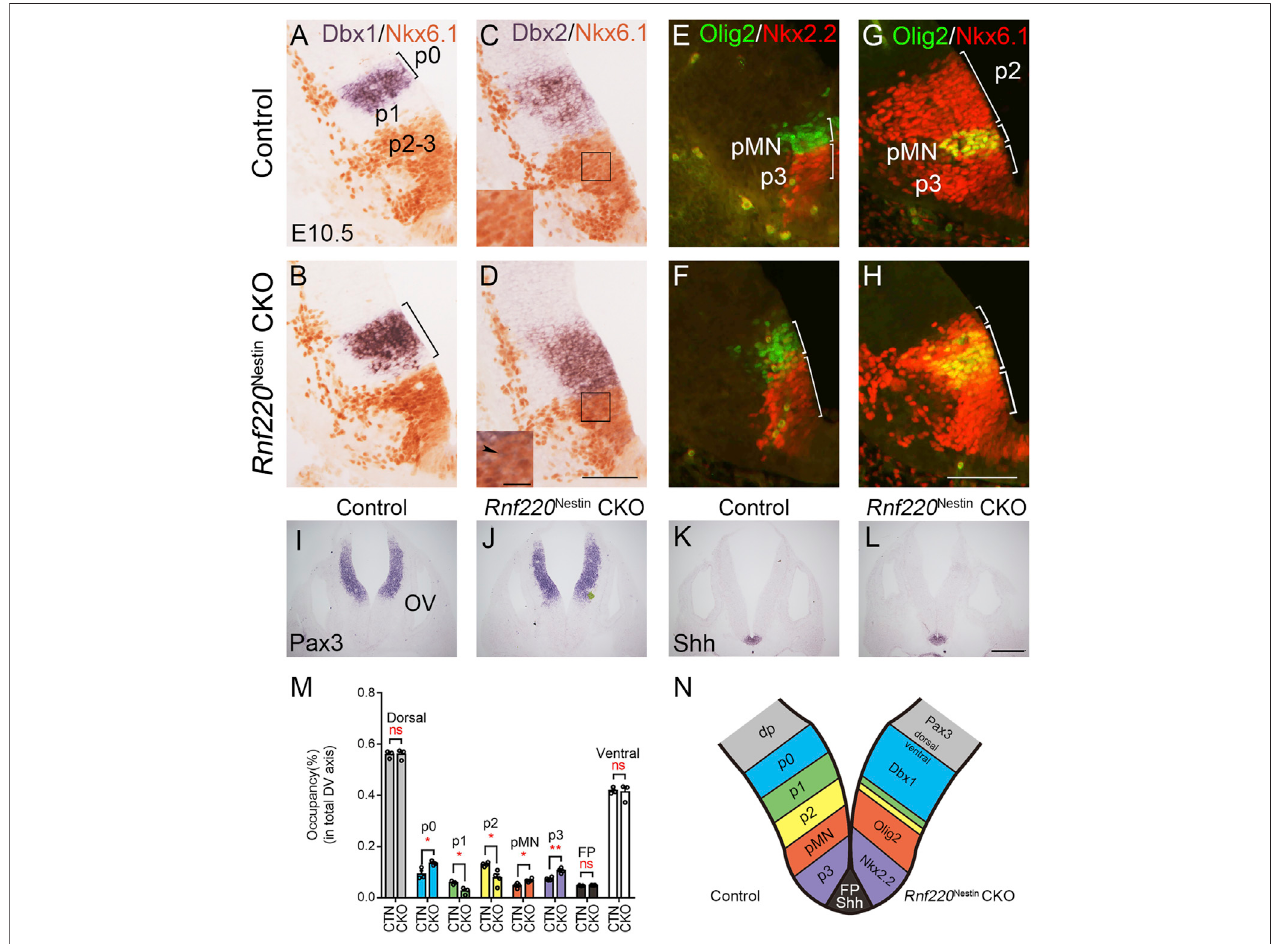
FIGURE2| TheProgenitorDomainsareAlteredintheDevelopingVentralHindbrainof Rnf220 Nestin CKOEmbryosatE10.5. (A,B) Insitu hybridizationfor Dbx1 and immunostaining for Nkx6.1 show that Dbx1 expression is expanded ventrally to the dorsal boundary of the Nkx6.1 + domain in Rnf220 Nestin CKO embryos (B) , whereas there is a gap region (i.e., the p1 domain) between the Nkx6.1 + and Dbx1 + domains in control embryos (A) . (C,D) In situ hybridization for Dbx2 and immunostaining for Nkx6.1 show that Dbx2 expression is expanded ventrally into the Nkx6.1 + domain in Rnf220 Nestin CKO embryos (D) (arrowhead), whereas a clear boundary betweentheNkx6.1 + andDbx2 + domainsispresentinthecontrolneuraltubes (C) .Scalebar,100 μ m (D) ;alsoappliesto (A – C) .Insetsarehigh-magni fi cationimagesof boxed areas in (C,D) . Scale bar, 25 μ m. (E,F) Double immunostaining shows that both the Nkx2.2 + (red) p3 domain and the Olig2 + (green) pMN domain are expanded alongtheDV axisofthe VZin Rnf220 Nestin CKO embryos (F) relative tocontrols (E) . (G,H) Double immunostaining forNkx6.1 (red) and Olig2 (green)showsadorsal shift oftheNkx6.1 + /Olig2 + pMN domainand areduction ofthep2 domaininthe Rnf220 Nestin CKOneural tubes (H) compared withcontrols (G) .Thep2domain corresponds totheNkx6.1 + regionlocateddorsaltotheNkx6.1 + /Olig2 + pMNdomain.Scalebar,100 μ m (H) ;alsoappliesto (E-G) . (I,J) Insitu hybridizationfor Pax3 ofcontrol (I) and CKO embryos (J) at E10.5. OV, otic vesicle. (K,L) In situ hybridization for Shh of control (K) and CKO embryos (L) at E10.5. Scale bar, 100 μ m (L) ; also applies to (I – K) . (M) Quanti fi cation of the sizes of each progenitor domain in the neural tube of control and Rnf220 Nestin CKO embryos. The size is shown by its proportion in the whole extent of the VZ along the DV axis. CTN, control; CKO, Rnf220 Nestin CKO. Dorsal, Pax3 + domain; p0, Dbx1 + domain; p1, gap region between the Dbx1 + and Nkx6.1 + domains; p2, Olig2 - domain in the dorsal part of the Nkx6.1 + region; pMN, Olig2 + domain; p3, Nkx2.2 + domain; FP, fl oor plate, Shh + domain. Data are expressed by mean ± SEM. Student ’ s t -test ( n ≥ 3 for each). *, p < 0.05; **, p < 0.01; ns, no signi fi cant difference. (N) Diagram showing the changes of the progenitor domains of the ventralhindbrainin Rnf220 Nestin CKO embryosat E10.5.The lossof Rnf220 leadstothe expansion oftheDbx1 + p0, Olig2 + pMN, and Nkx2.2 + p3domains intheventral hindbrain neural tube at the expense of the middle domains (i.e., the p1 and p2 domains) without affecting the extent of the dorsal neural tube.